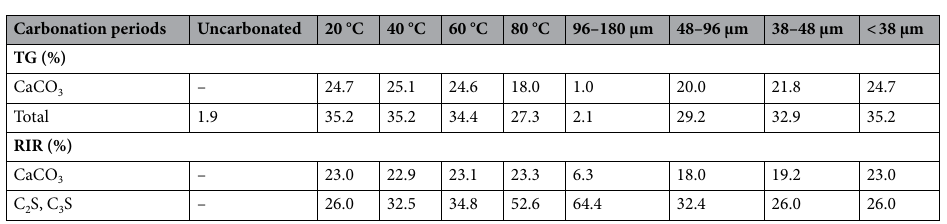
Table 2. Changes in the LFS mineral phase composition determined by TG and RIR at different hydration and carbonation reaction temperatures and particle sizes.